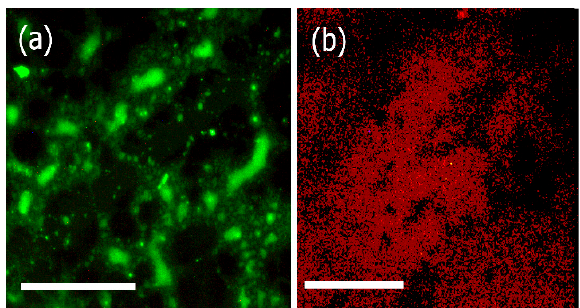
Figure 6. Fluorescence microscopy images of ( a ) FITC labeled laminin α -2 antibody bound to laminin bound assemblies; ( b ) Rhodamine labeled collagen IV antibody bound to biocomposite assemblies (collagen IV-artemin-laminin bound Ile-TMG-Ile). Scale bars = 20 μ m.